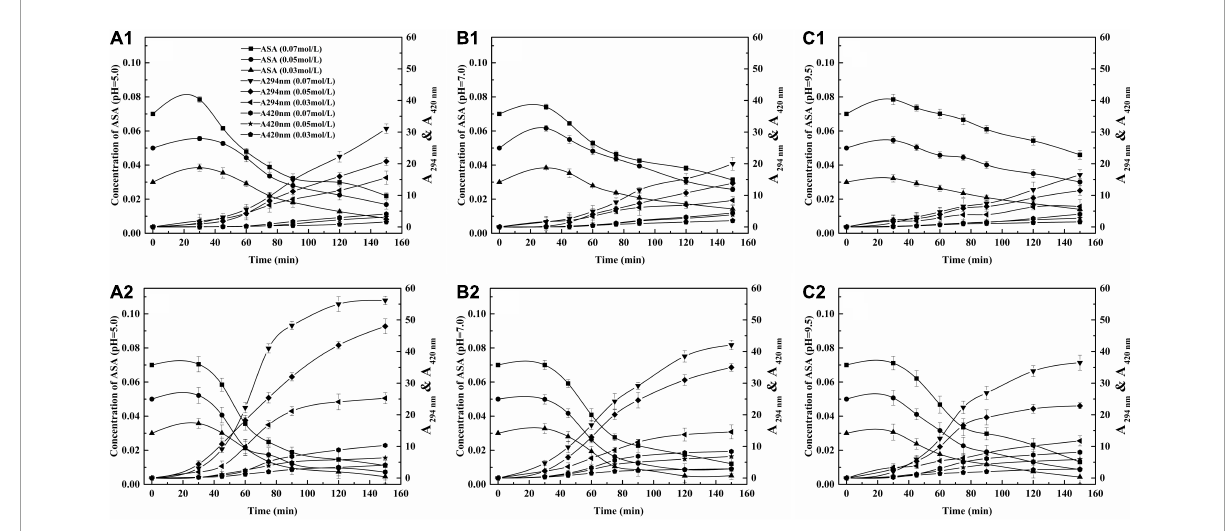
FIGURE3 The relationship between concentration of ASA, A 294 nm and A 420 nm . (A) pH = 5.0, (B) pH = 7.0, (C) pH = 9.5; 1, 150 ◦ C, 2, 190 ◦